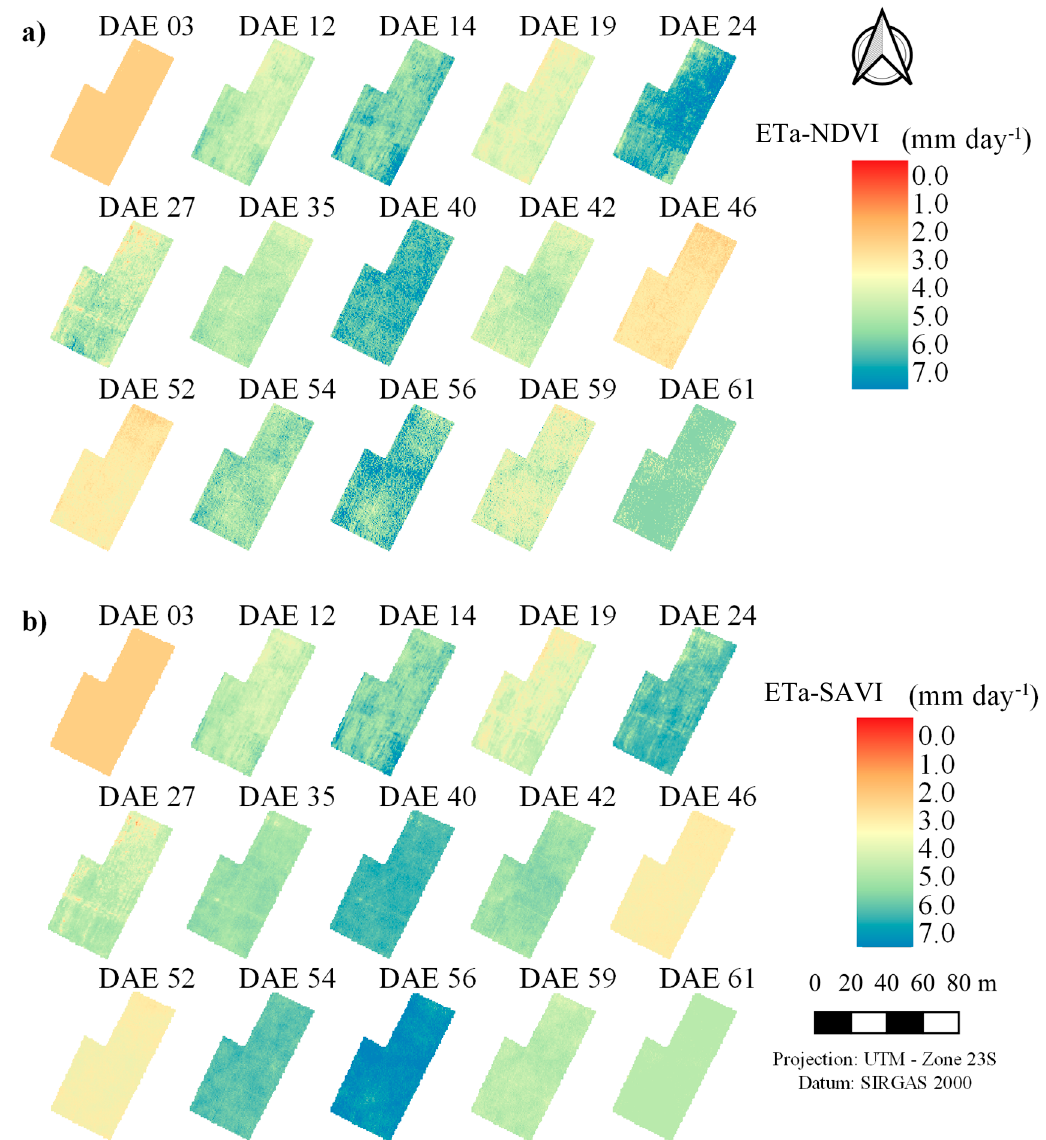
Figure 8. Actual evapotranspiration of the crop using the empirical models derived from the NDVI ( a ) and SAVI ( b ).